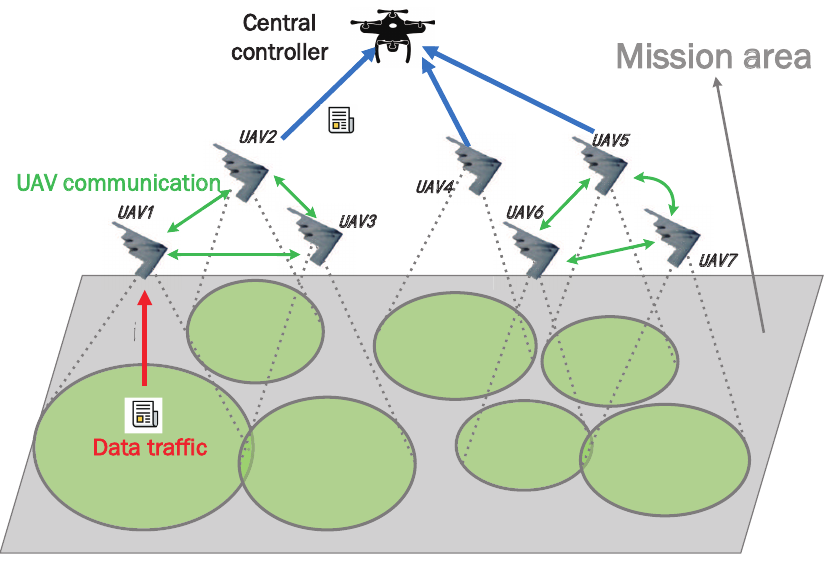
Figure 1. A diagram of unmanned aerial vehicle (UAV) coverage in a mission